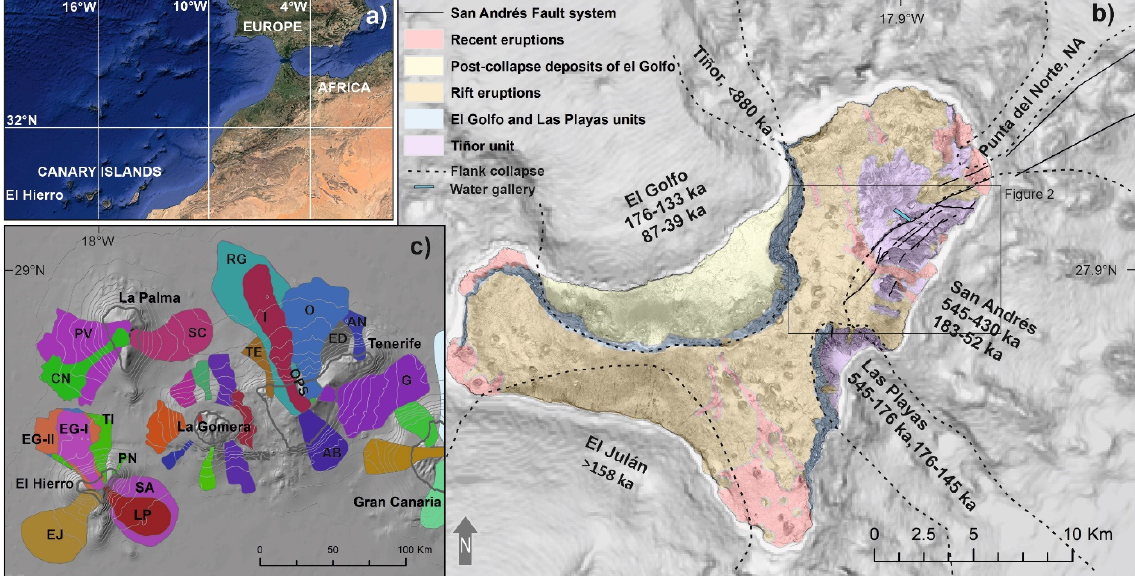
Figure 1. Location ( a ) and geological ( b ) maps of El Hierro. The latter contains the ages of the known volcanic flank collapses (NA—not ascertained). The inset map ( c ) provides an overview of the main landslides on the Western Canary Islands (DEM with 100 m resolution, outlines from the [2]